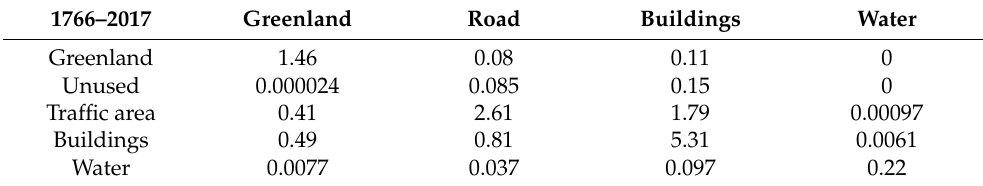
Table 4. Land use transfer matrix from 1766 to 2017/km 2 .